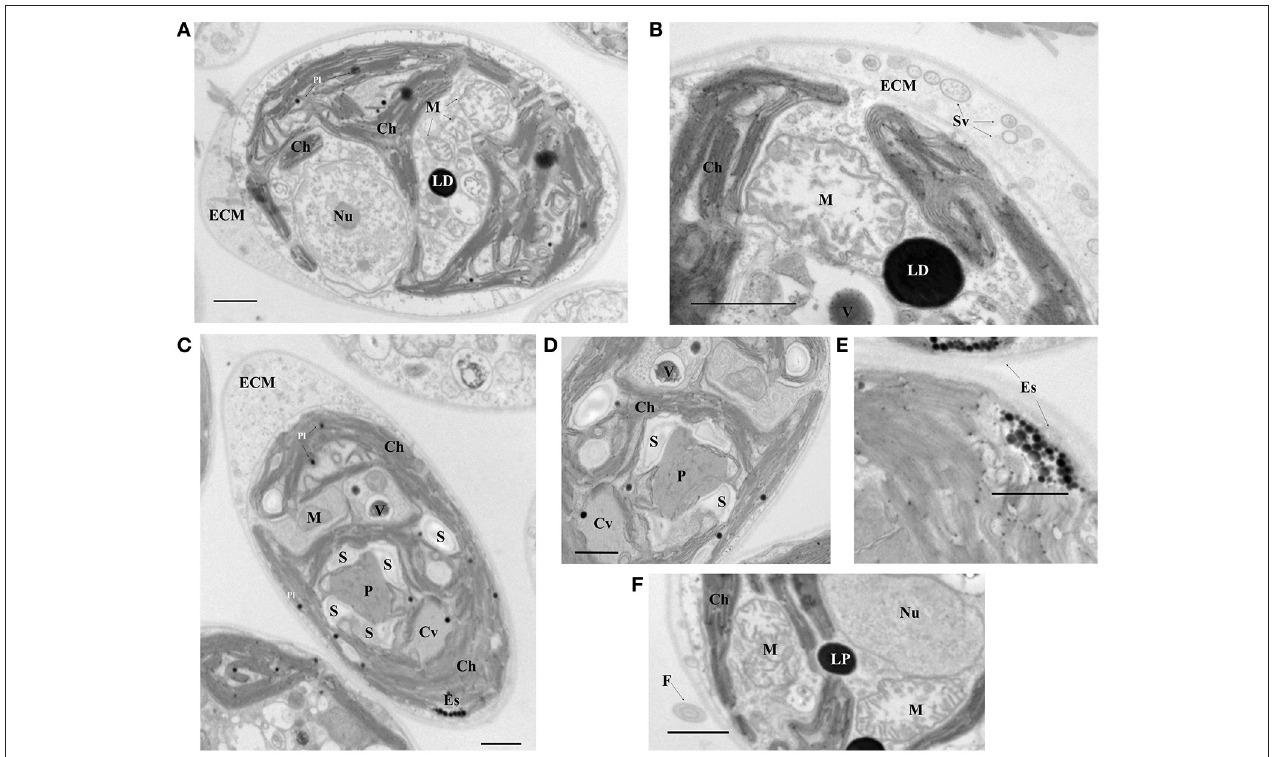
FIGURE 3 | Electron micrographs of the ChlSP strain. (A,C) Transverse sections of a single cell; (B,D–F) close up of cell components— (B) cell wall and detail of a mitochondria, (D) pyrenoid, (E) eyespot, and (F) flagellum. Scale bars, 1.0 µ m. (Ch, chloroplast; M, mitochondrial profiles; Nu, nucleolus within the nucleus; Pl, plastoglobules; LP, lipid droplets; P, pyrenoid; S, starch F, flagellum; Es, Eye spot; ECM , extracellular matrix; Sv, secretory vesicles; Cv, contract vacuole profile; V, vacuole with possible U